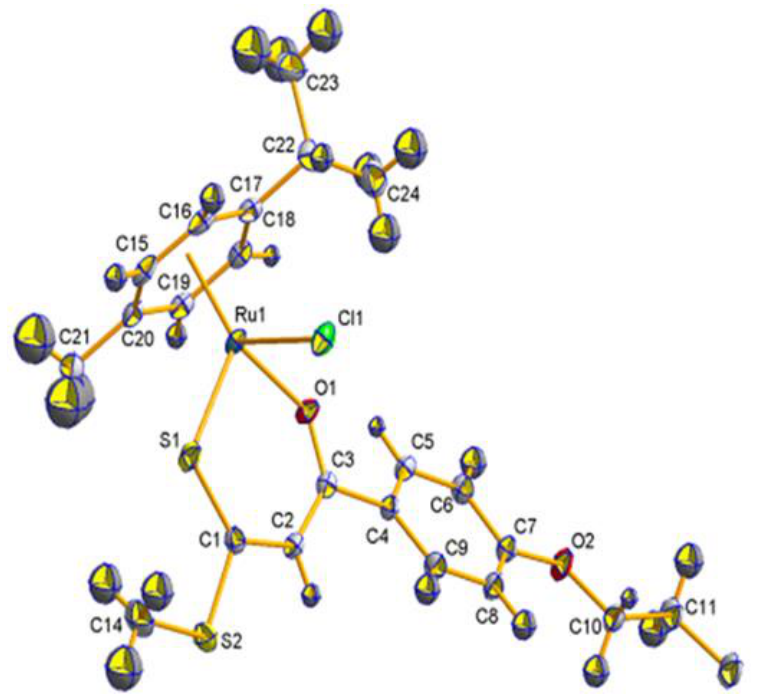
Figure 4. Molecular structure (50% probability) of Ru14.